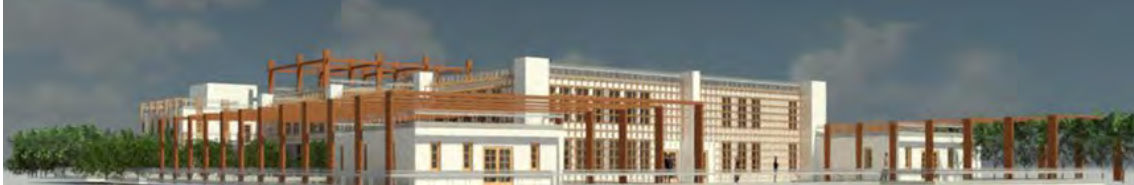
Figure 19. Showing the Elevation with the wooden shades (“Ahmed Yousry’s”